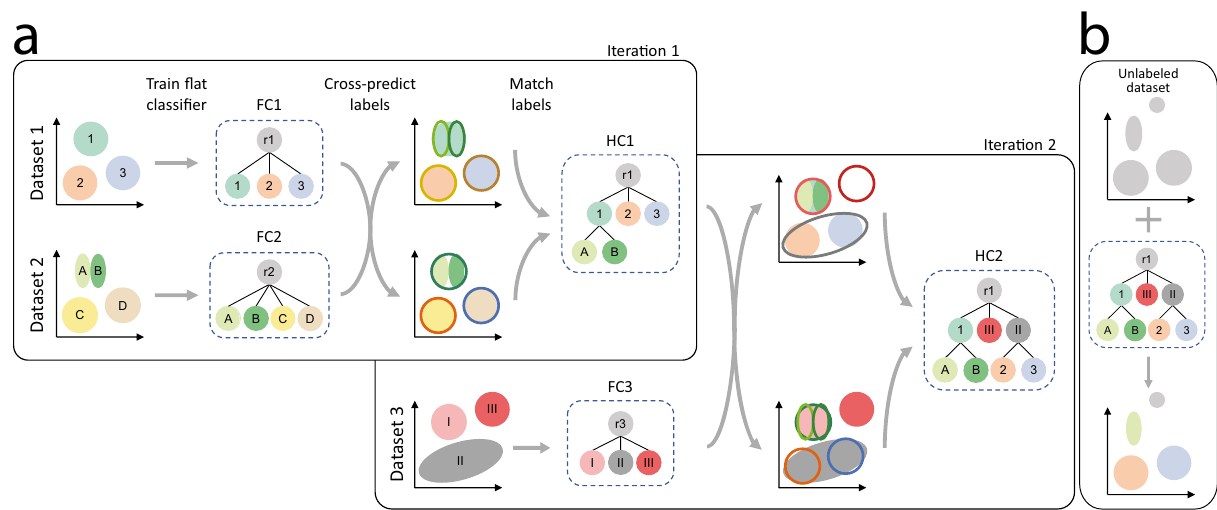
Fig. 1 Schematic overview of scHPL. a Overview of the training phase. In the fi rst iteration, we start with two labeled datasets. The colored areas represent the different cell populations. For both datasets a fl at classi fi er (FC1 and FC2) is constructed. Using this tree and the corresponding dataset, a classi fi er is trained for each node in the tree except for the root. We use the trained classi fi cation tree of one dataset to predict the labels of the other. The decision boundaries of the classi fi ers are indicated with the contour lines. We compare the predicted labels to the cluster labels to fi nd matches between the labels of the two datasets. The tree belonging to the fi rst dataset is updated according to these matches, which results in a hierarchical classi fi er (HC1). In dataset 2, for example, subpopulations of population “ 1 ” of dataset 1 are found. Therefore, these cell populations, “ A ” and “ B ” , are added as children to the “ 1 ” population. In iteration 2, a new labeled dataset is added. Again a fl at classi fi er (FC3) is trained for this dataset and HC1 is trained on datasets 1 and 2, combined. After cross-prediction and matching the labels, we update the tree which is then trained on all datasets 1 – 3 (HC2). b The fi nal classi fi er can be used to annotate a new unlabeled dataset. If this dataset contains unknown cell populations, these will be rejected.